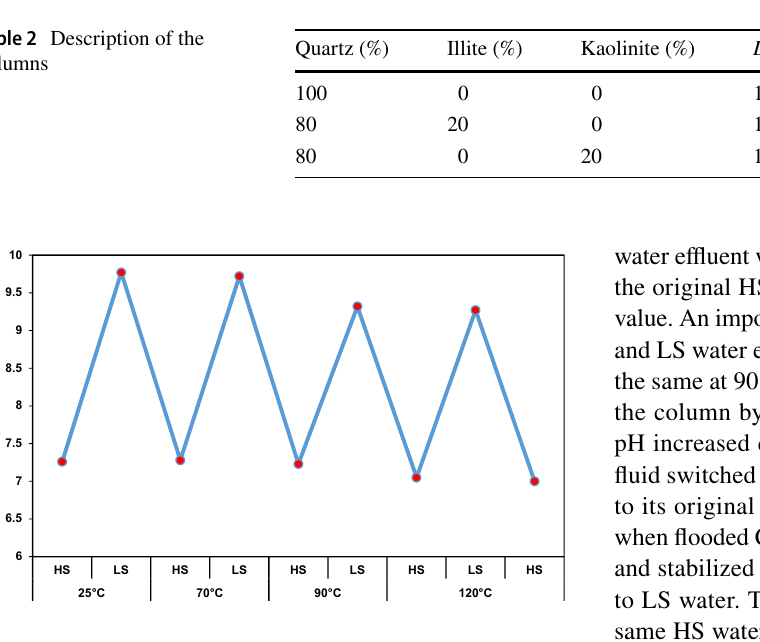
Fig. 2 Effluent pH from sand column, at 25, 70, 90, and 120